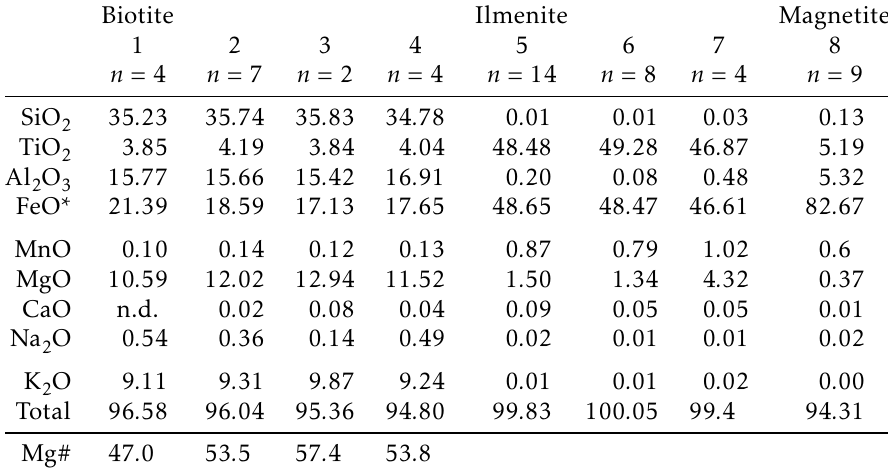
Table 5: Mean compositions of biotite and Fe-Ti oxides. *Total Fe as FeO. n = number of analyses; n.d. = not de- tected (below detection limit). Comments on biotite occurrence: 1: interpreted as biotite antecrysts; 2: inclusions in garnet; 3: inclusions in brown hornblende; 4: biotite in metasedimentary enclave. Comments on Fe-Ti oxides occurrence: 5: ilmenite inclusions in garnet; 6: ilmenite microcrysts in the groundmass; 7: ilmenite inclusions in brown hornblende. 8: titano-magnetite microphenocrysts in crystallised melt hollows shielded in garnet (see Figure 10). Recalculated values: FeO = 35.63, Fe O = 52.27, Total = 2 3